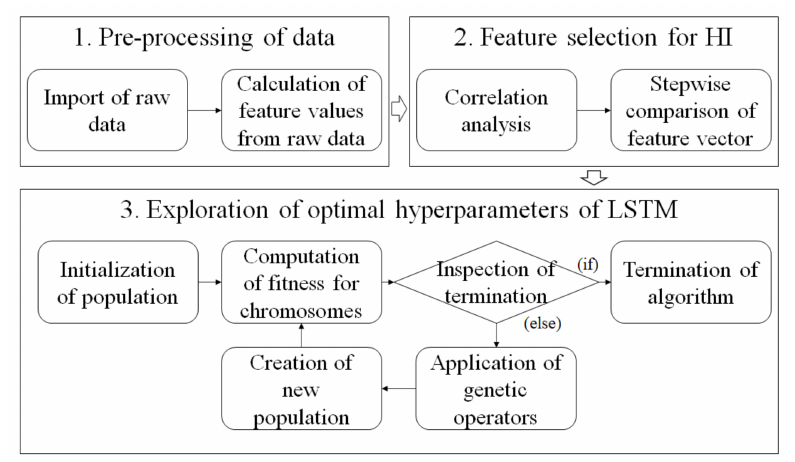
Figure 3. Suggested procedure for optimizing design